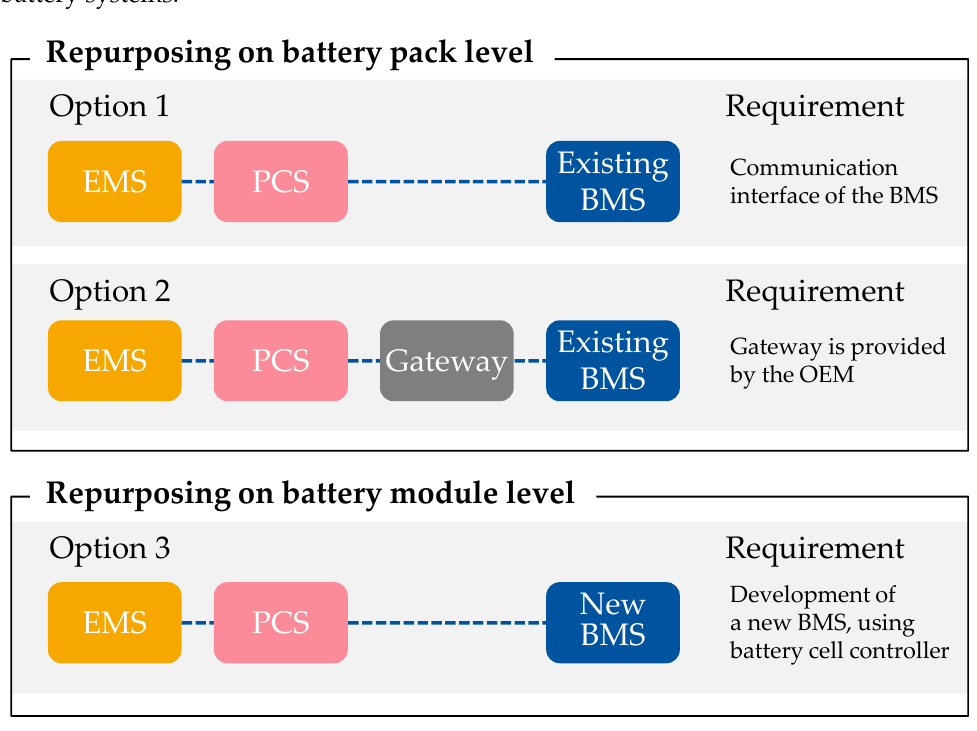
Figure 3. Repurposing options depending on the BMS communication.